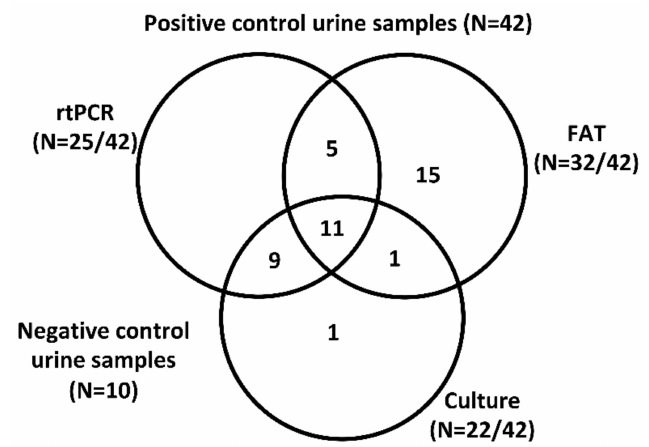
Figure 2. Venn diagram of test-positive bovine urine samples (N = 42 total). Numbers of bovine samples which were positive for Leptospira by FAT and / or culture and / or rtPCR are provided. Only 26% (11 / 42) samples were considered positive by all three